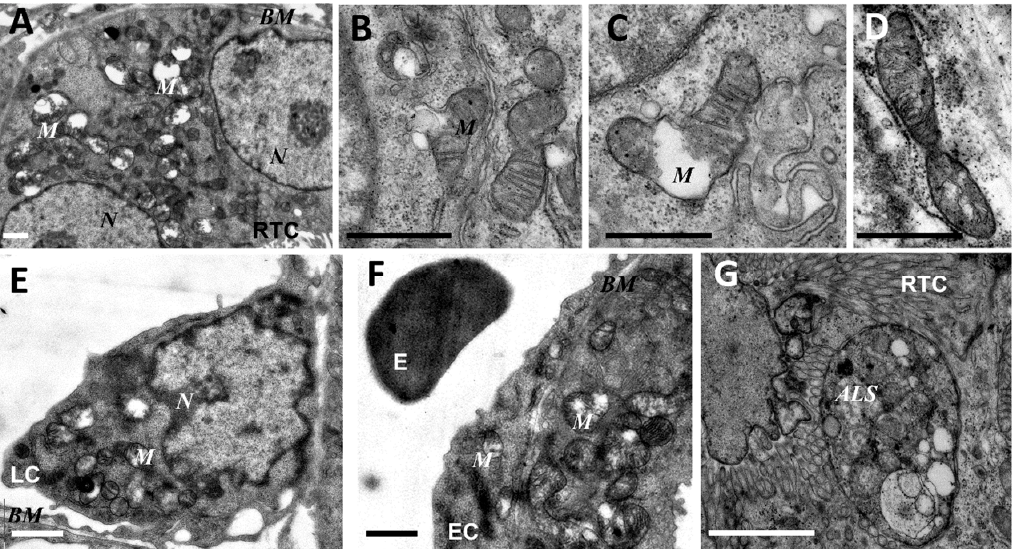
Figure 2. Ultrastructural changes in mitochondria of renal tubular cells ( A – D , G ), endothelium ( F ), and leukocytes ( E ) after lipopolysaccharide (LPS) administration. Renal tubular cells (RTC), endothelial cells (EC), and leukocytes (LC) contain mitochondria (M) with damaged structures. Alterations in mitochondrial morphology, ultimately, are expressed by extensive swelling of inter-cristae space and matrix. BM, basal membrane; N, nucleus; ALS, autophagolysosome; E, erythrocyte in the vessel. Scale bar, 1 μ m.